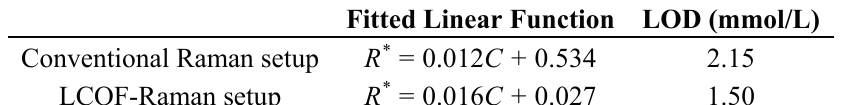
Table 2. The fitted linear functions and LODs of conventional Raman and LCOF-Raman experimental setup. (QE65000 is employed as spectrometer, and the length of the LCOF is 100